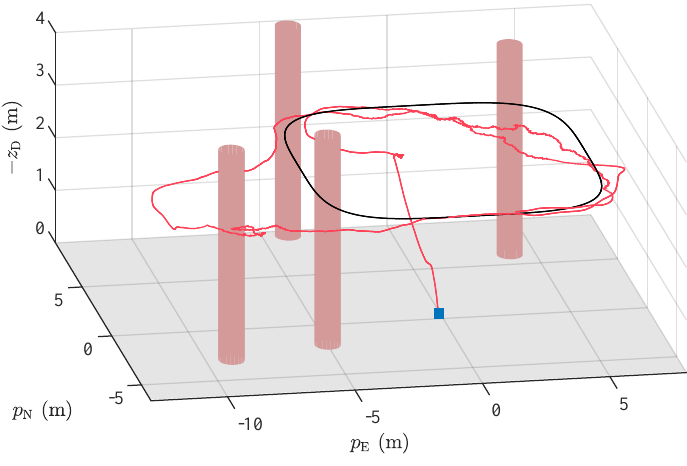
Figure 10. Three-dimensional path estimated by Robust Adaptive Unscented Kalman Filter (RAUKF) (red) for the target path represented by the black curve. The vehicle starting point is represented by the blue square. Observe that the estimated path deviates from the target one due to presence of trees, represented by brown cylinders. Note that, as the diameter and position of the trees are not known, such cylinders are approximations of the actual forest and are used for visualization